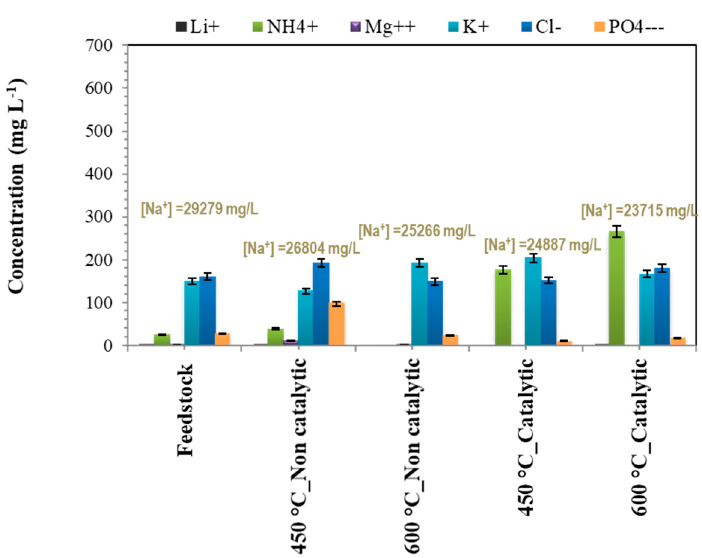
Figure 8. Aqueous phase analyses (cations and anions concentration).